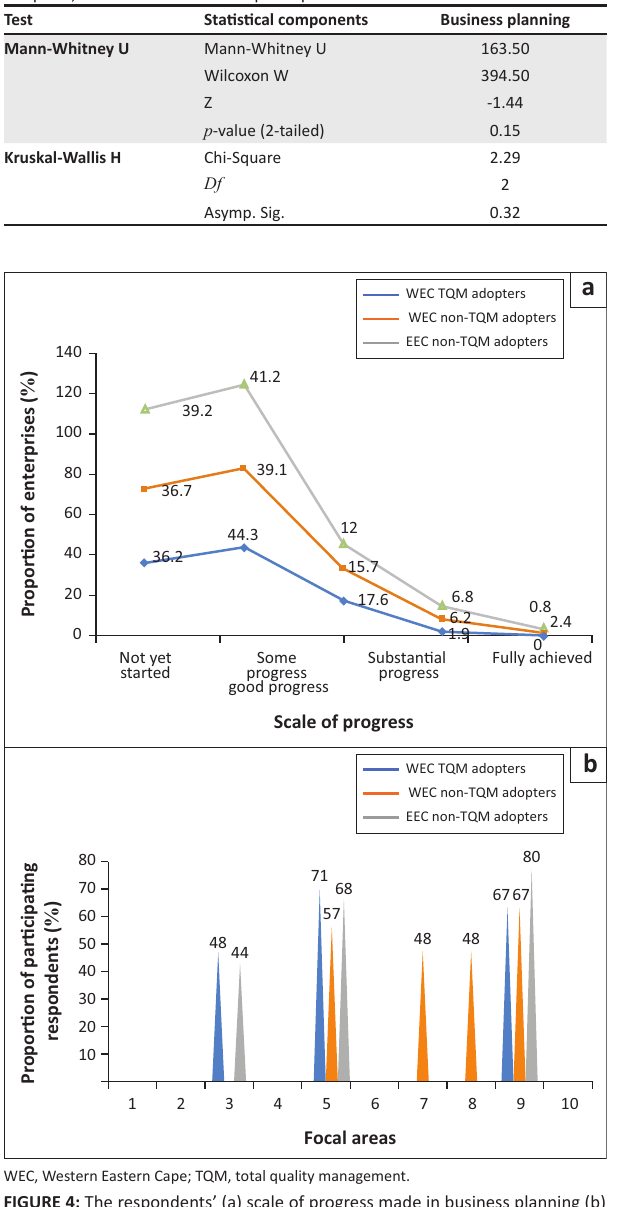
TABLE 4 : Results of the Mann-Whitney U and Kruskal-Wallis H tests for comparing the business planning performance scores of Western Eastern Cape